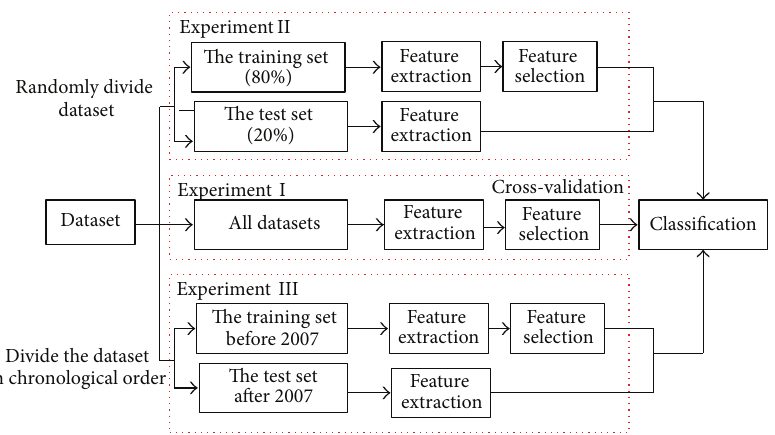
Figure 2: The architecture of our